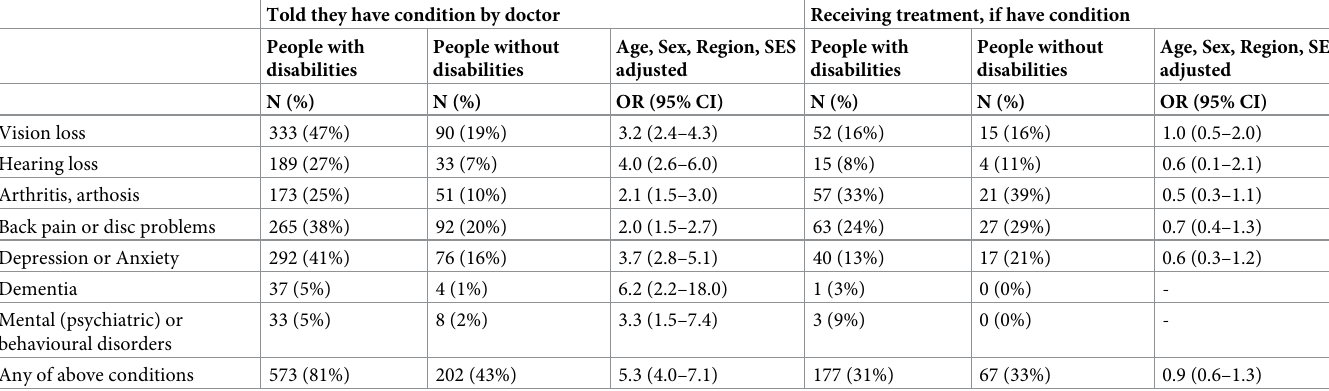
Table 4. Coverage of treatment for impairment-related health conditions, comparing people with and without